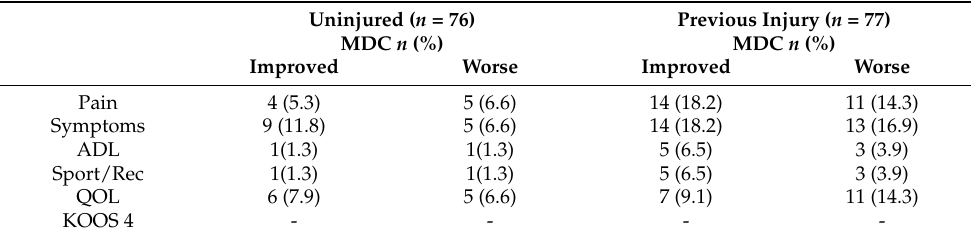
Table 3. Frequency and proportion ( n (%)) of uninjured and injured participants with improved or worse KOOS scores by minimal detectable change (MDC) in a 23.4 months (range 8 to 42 months) follow-up.